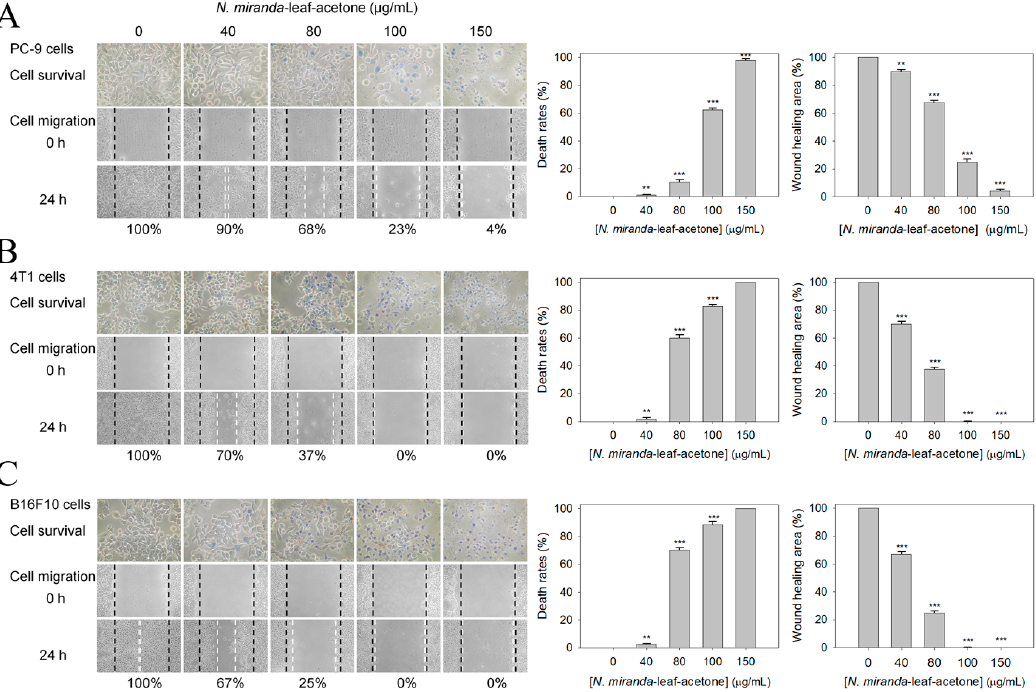
Figure 4. Cytotoxic effects of N. miranda -leaf-acetone on the survival and migration of ( A ) PC-9, ( B ) 4T1, and ( C ) B16F10 Cells. Different concentrations of N. miranda -leaf-acetone (0, 40, 80, 100, and 150 μ g/mL) were used to demonstrate the cytotoxic effects on the survival and migration of these cancer cells. Trypan blue assay was performed to estimate the cell death rates and wound-healing assay was used to estimate the cell migration capacities. ** p < 0.01 and *** p < 0.001 compared with the control group.